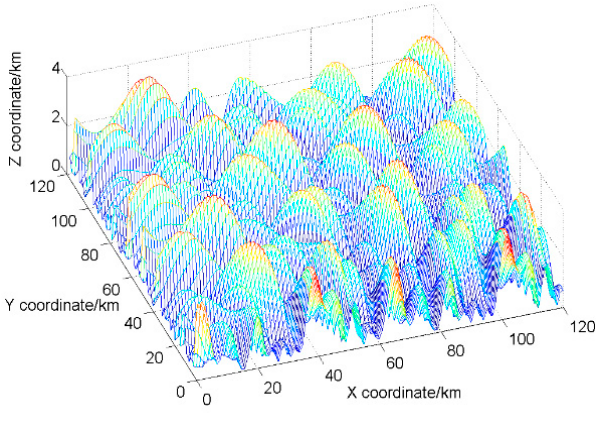
Figure 2. The image of the 3D undulating terrain environment.